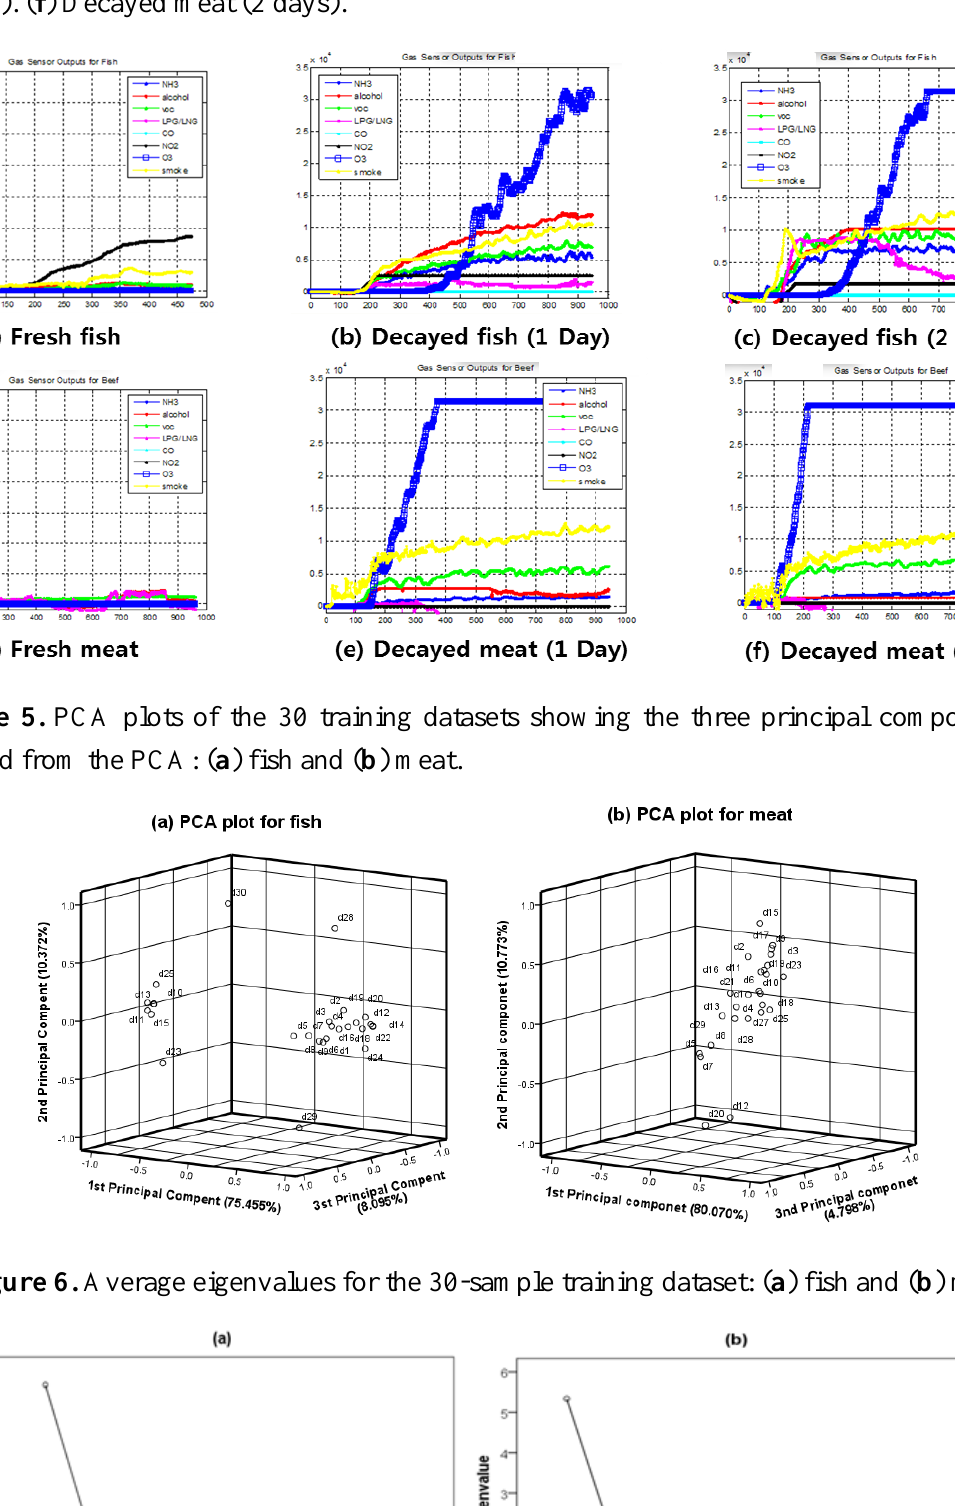
Figure 4. Comparison of the output of beef and fish (mackerel). ( a ) Fresh fish. ( b ) Decayed fish (1 day). ( c ) Decayed fish (2 days). ( d ) Fresh meat. ( e ) Decayed meat (1 day). ( f ) Decayed meat (2 days).